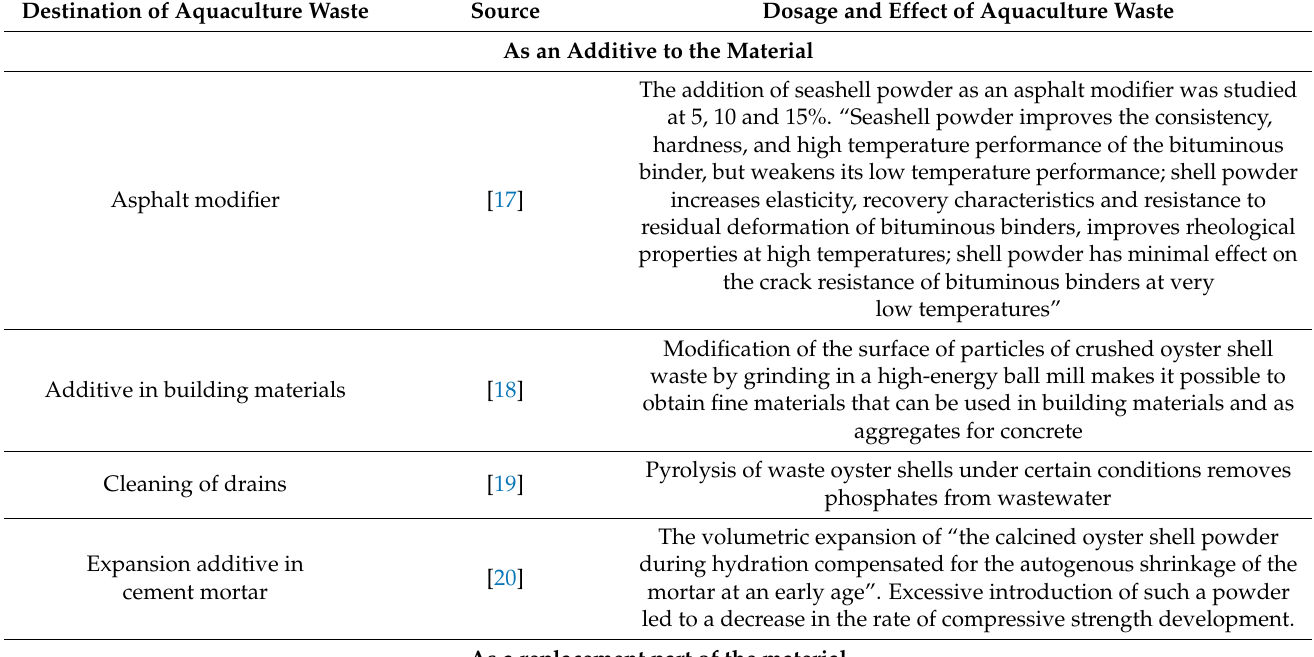
Table 1. Purpose of shells in cement materials and their influence on